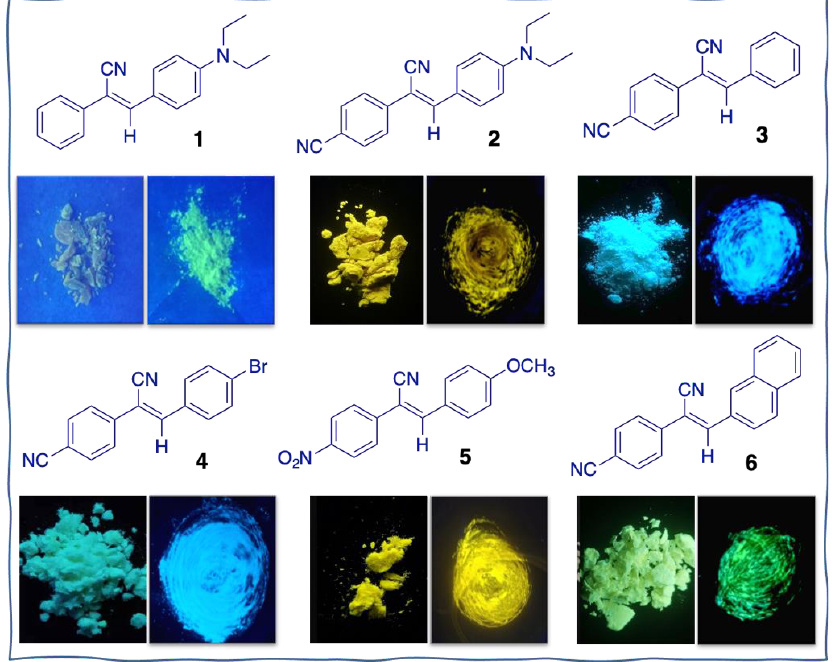
Figure 1. Molecular structures of 1 – 6 and their photographs were taken before and after grinding under 365 nm UV light.